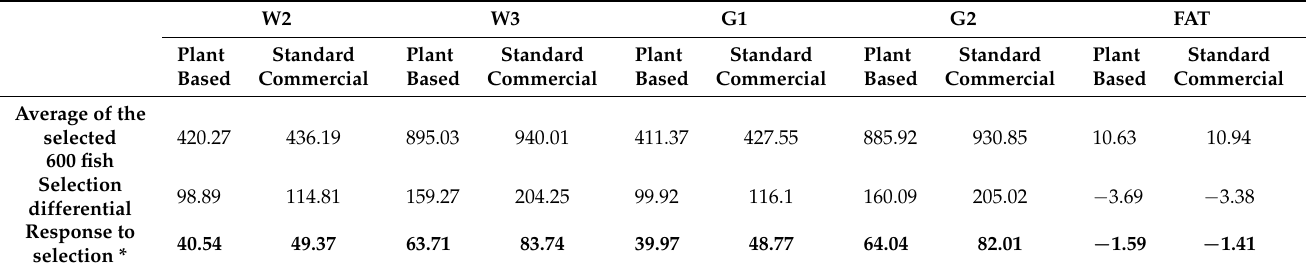
Table 8. Prediction of the response to selection for the body weight performance, growth and